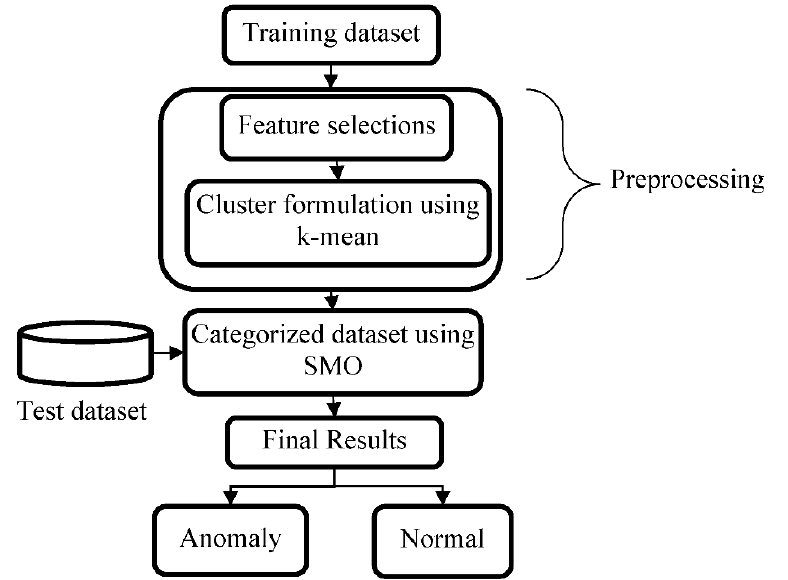
Figure 2. Model for machine learning-based anomaly detection with a hybrid data mining algo- rithm.